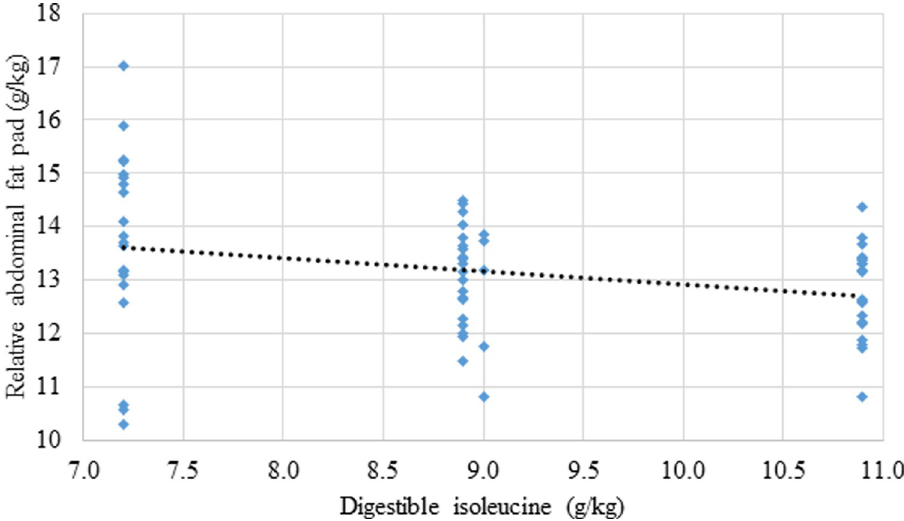
Fig 3. Linear relationship (P = 0.022; r = -0.284) between dietary isoleucine concentrations and relative abdominal fat-pad weights where: Relative fat pad weight (g/kg) = 15.42–0.251 × digestible isoleucine (g/kg) .